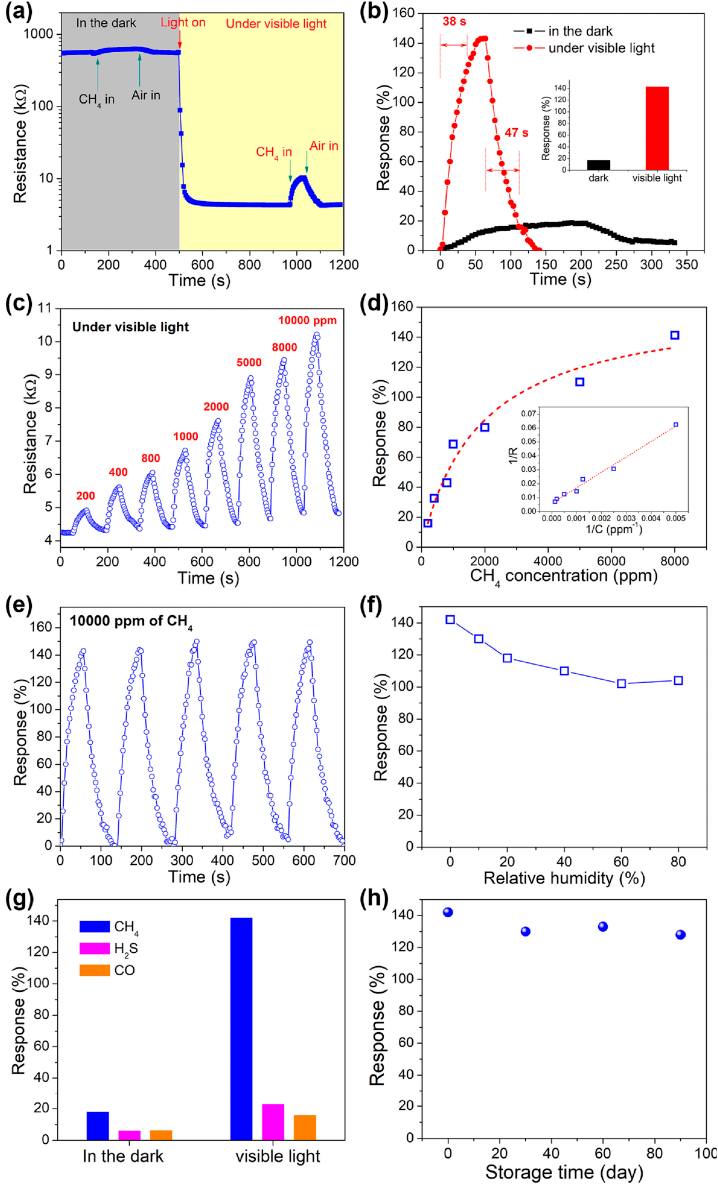
Figure 6. ( a ) Kinetics of resistance change of the Ti 2 CT x sensor with 10,000 ppm of CH 4 measured continuously with visible-light irradiation on/off; ( b ) dynamic response curves and response values of the Ti 2 CT x sensor to 10,000 ppm of CH 4 with and without visible-light irradiation; ( c ) dynamic response curve and ( d ) responses of the Ti 2 CT x sensor when 200–10,000 ppm of CH 4 was applied under visible-light irradiation; inset in ( d )—linear fitting of 1/R versus 1/C; ( e ) reproducibility of the Ti 2 CT x sensor with 10,000 ppm of CH 4 (5 cycles); ( f ) effect of relative humidity on the sensor re- sponse; ( g ) selectivity of the Ti 2 CT x sensor to CH 4 over H 2 S and CO with visible-light irradiation; ( h ) long-term stability of the sensor after storage in air. Reprinted with permission from [100]. Copy- right 2021: Elsevier B.V. A respective reduction of response time from 136 s to 38 s has been noted, too. It is worth noting that here the humidity also plays an important interference role. When the